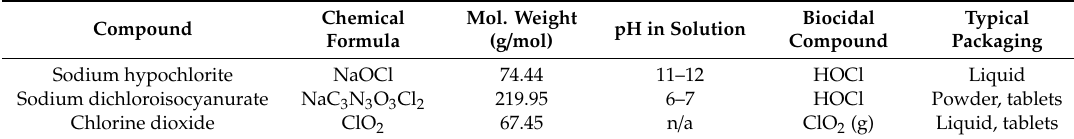
Table 1. Characteristics of the three tested